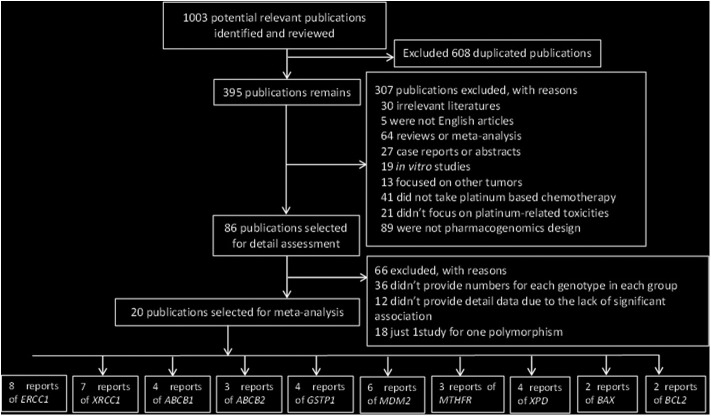
Flow chart of literature selection.